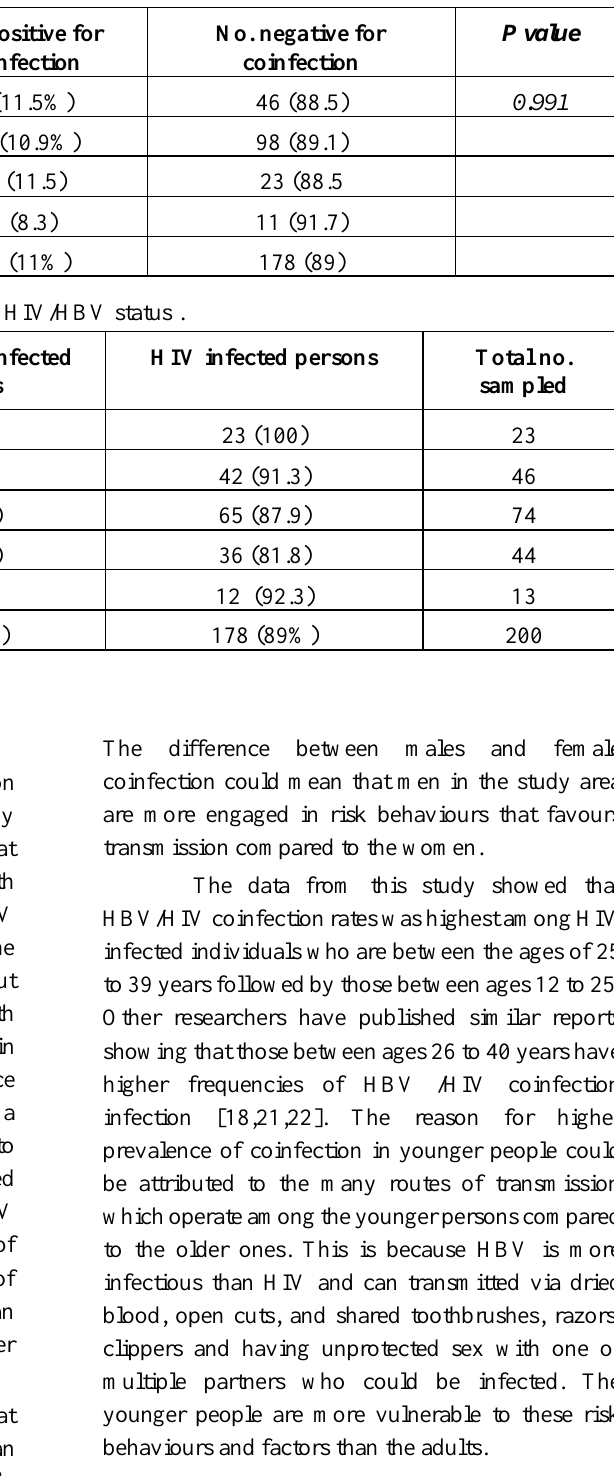
Table 3. Distribution of HBV/HIV coinfection in relation to marital status.